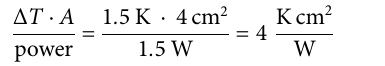
Frontiers in Physics |